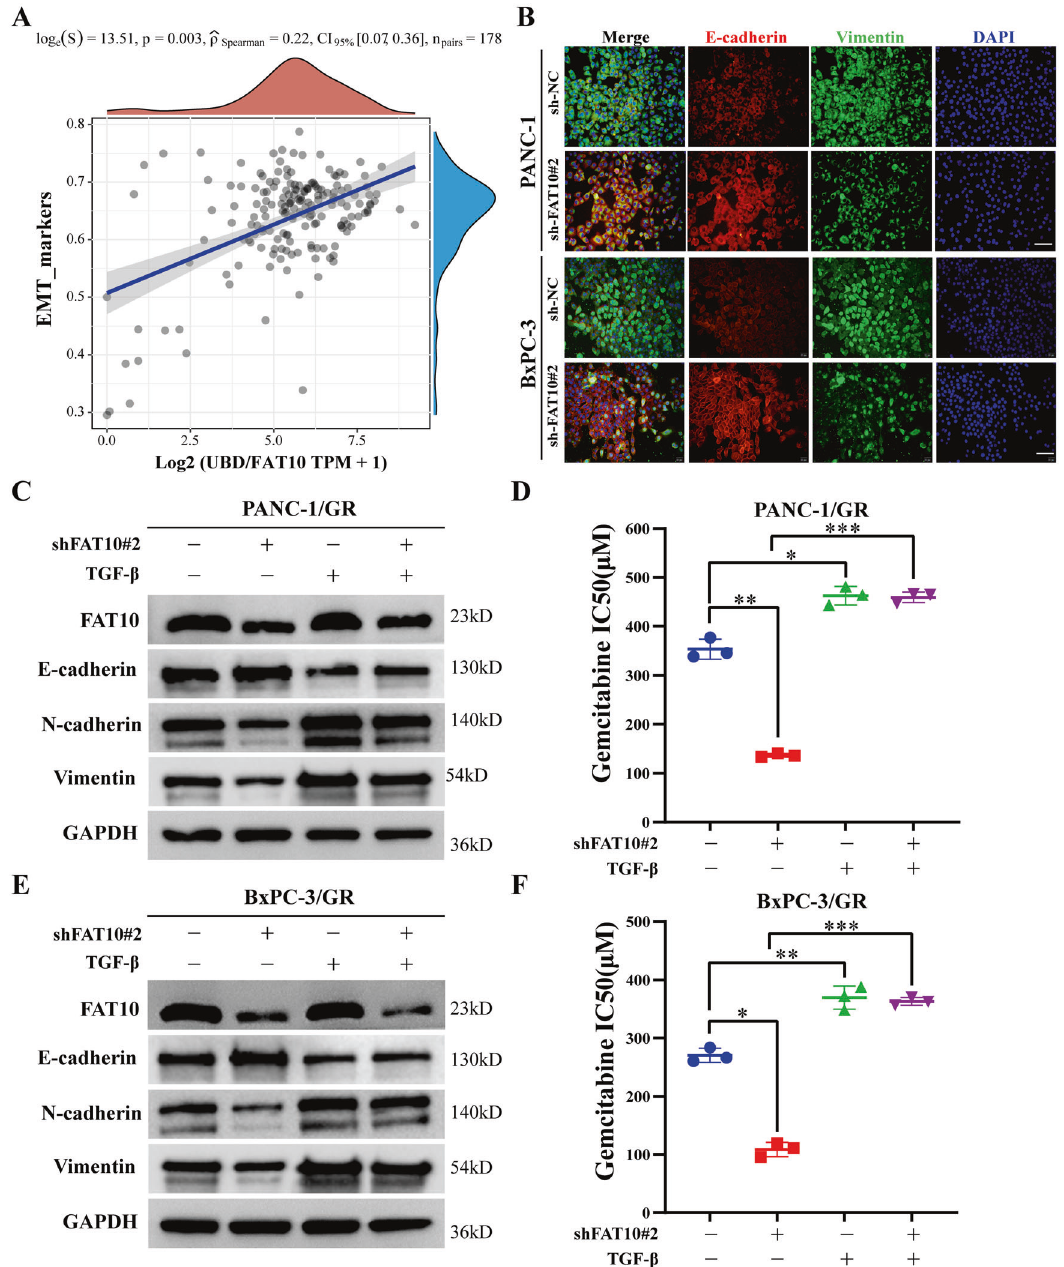
Fig. 4 FAT10 regulates EMT to promote chemotherapeutic resistance in PC cells. A Spearman correlation analysis of the correlation between FAT10 ( UBD ) and EMT pathway score. FAT10 expression is represented by the abscissa, and the EMT pathway score is represented by the ordinate. A density curve to the right represents the trend in the distribution of pathway scores, a density curve to the upper part represents the trend in the distribution of gene expression. The top part shows the p -value, correlation coef fi cient, and correlation calculation method. B Immuno fl uorescence analysis of the effect of inhibiting FAT10 on the expression of EMT-related proteins (E-cadherin and Vimentin) in PC cells. Scale bar, 50 μ m. C – F GEM-resistant PC cell lines (PANC-1/GR and BxPC-3/GR) were transfected with interfering plasmid sh-FAT10#2 and or EMT activator (TGF- β , 10 ng/mL) for 48 h. C , E Western blot analysis was used to observe the expression of EMT-related proteins in each treatment group. D , F Cell viability experiments were used to calculate the half-inhibitory concentration (IC50) of GEM-treated PC-resistant cells in each treatment group. Data represent the mean ± SD of triplicate experiments and were statistically analyzed by one-way ANOVA. * p < 0.05, ** p < 0.01, *** p < (Fig. 7A). We previously found that FAT10 stabilizes the substrate FAT10 inhibits FOXM1 protein ubiquitination degradation by by competing with ubiquitin (Ub) and ultimately reducing competing with ubiquitin to bind to FOXM1 substrate ubiquitination [7, 8]. Therefore, we tested if FAT10 To further clarify the role of FAT10 in the degradation of competes with Ub to bind FOXM1 and inhibits the ubiquitination FOXM1, we fi rst needed to determine whether FAT10 and FOXM1 and degradation of FOXM1 in PC cells by treating PANC-1 and proteins directly interact. Co-IP assay results suggested a possible BxPC-3 cells with MG132 to inhibit proteasome-mediated interaction between FAT10 and FOXM1 proteins in PC cells